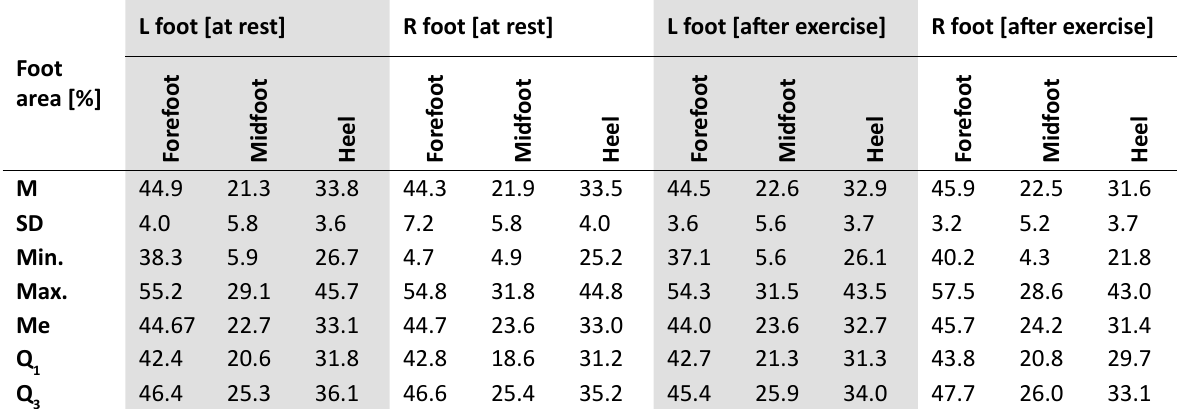
Legend: L – left, R – right, M – the arithmetic mean of a sample, SD – standard deviation, Min. – minimum value of a sample, Max . – maximum value of a sample, Me – the middle average of a sample, Q